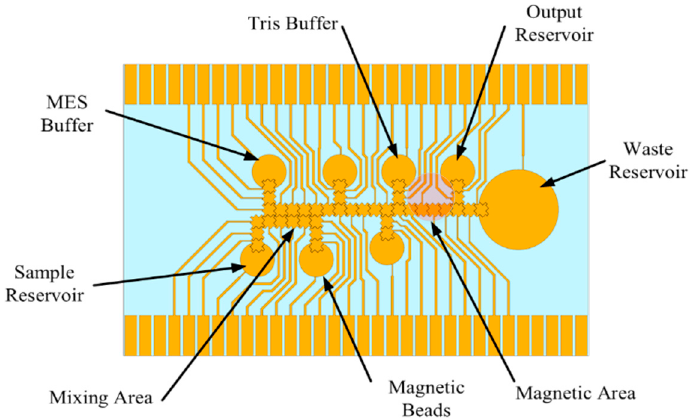
Figure 11. Magnetic bead EWOD chip layout .